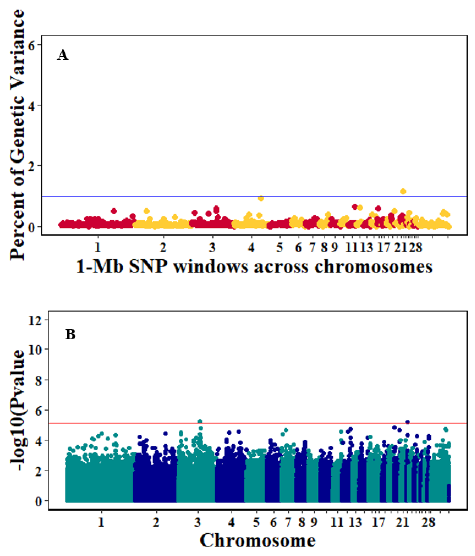
Figure 3. Manhattan plots showing the genome-wide association results for pre-infection growth rate using Bayes-B and single-SNP analyses. ( A ) Bayes-B results show the percent of genetic variance explained by 1-Megabase (1-Mb) non-overlapping window of SNPs across chromosomes. ( B ) Single-SNP results show the − log 10 ( p- value) of ordered SNPs across the chromosomes. The blue and red lines indicate genome-wide significance at 1% genetic variance and 20% genome-wise significance.